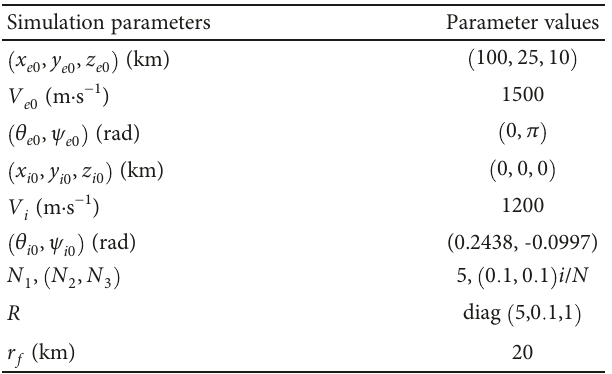
Table 2: The initial values of conditions of the attack side and the defense side.